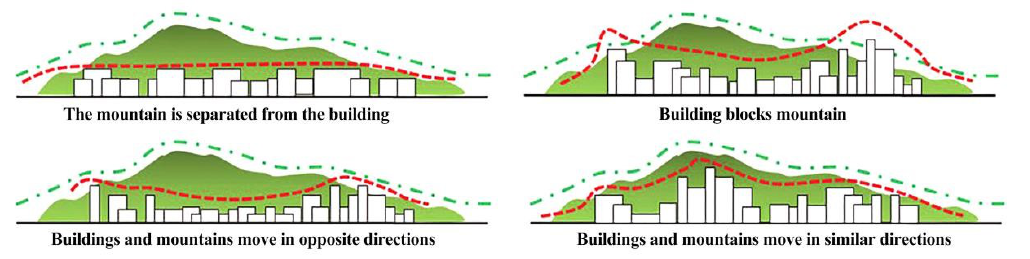
Fig. 5 Schematic diagram of the relationship between the building and the mountain